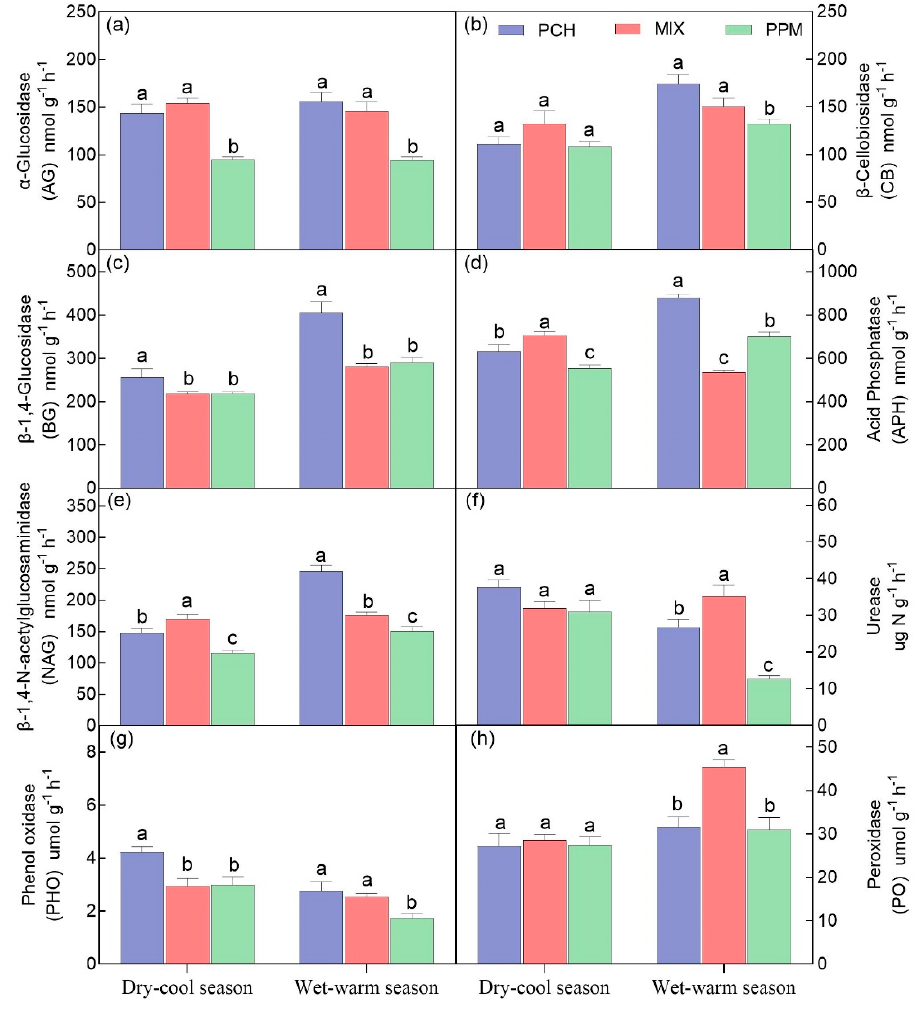
Figure 5. Soil extracellular enzyme activities (( a – f ) refer to hydrolases, ( g , h ) refer to oxidases) in three plantations in different seasons. Error bars are standard error. Different letters above the bars denote significant differences at p < 0.05 level by LSD multiple comparisons among stand types ( n = 5).